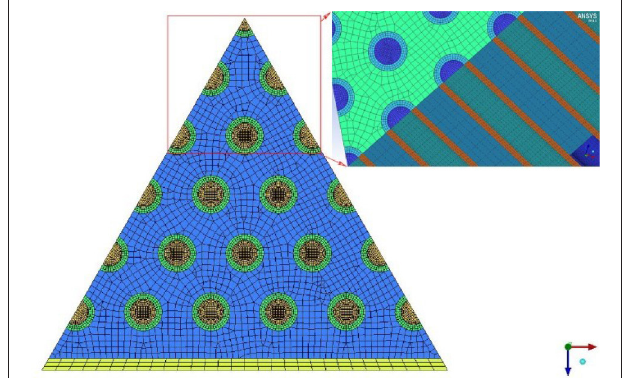
FIGURE 9 | Cross sectional mesh of the 91 coolant channel fuel element and a zoomed-in view of center part.